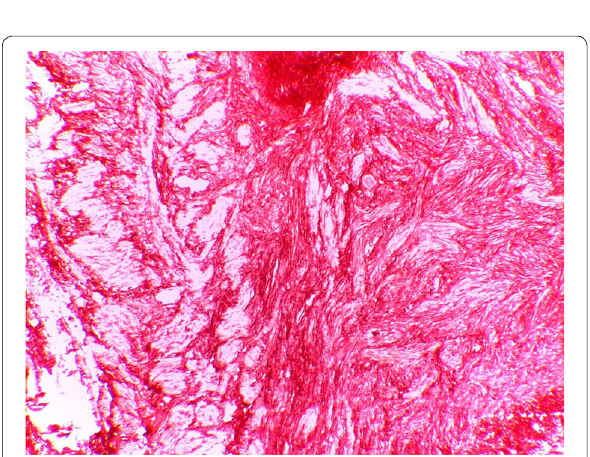
Fig. 2 Dark red-stained collagenous bundles in pink fibrohyaline background “syrus red ×